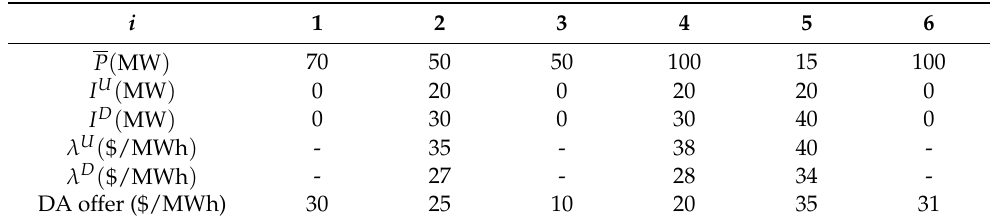
Figure 2. Six-node test system. Table 2. DA schedule, upward offers and downward bids of generating units.